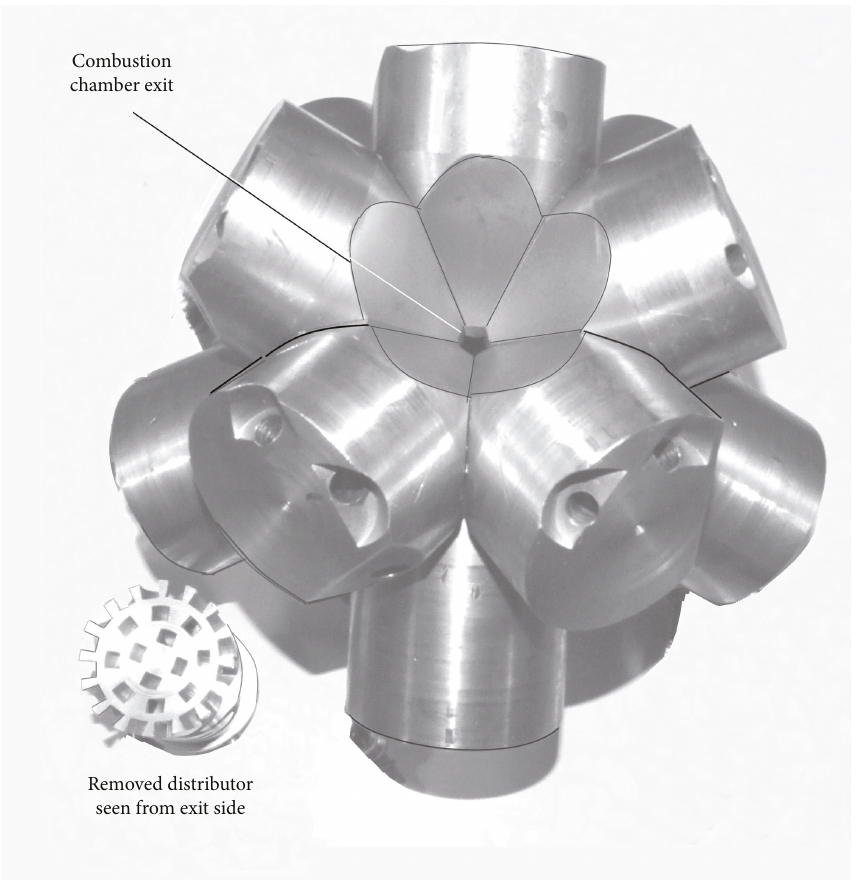
Figure 2: Photograph of the test combustion chamber — actually seen from below where there is the exit for the generated plasma. At the bottom picture on the left is one of the detonation wave distributors seen from the side of the entrances into the